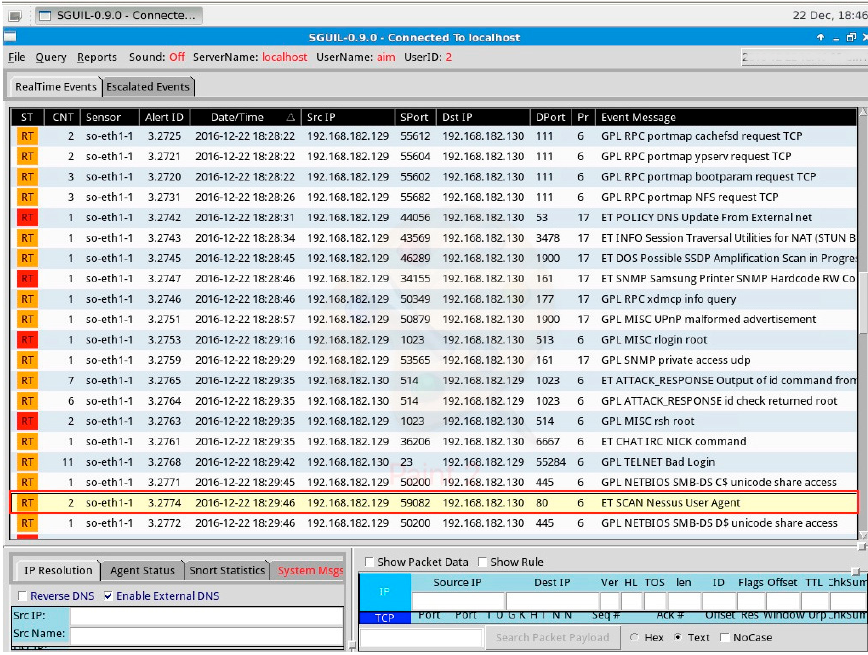
Figure 7. Sguil Output: Nessus Vulnerability Scan.